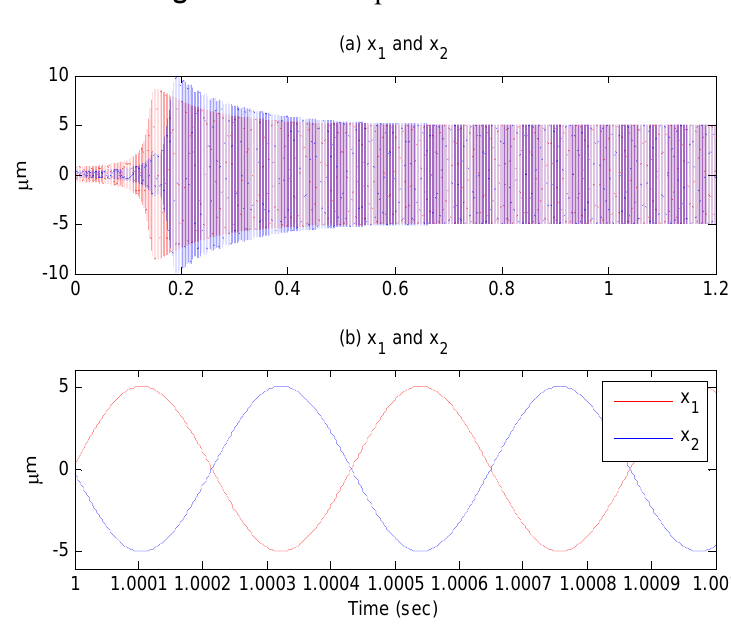
Figure 4. Time response of drive